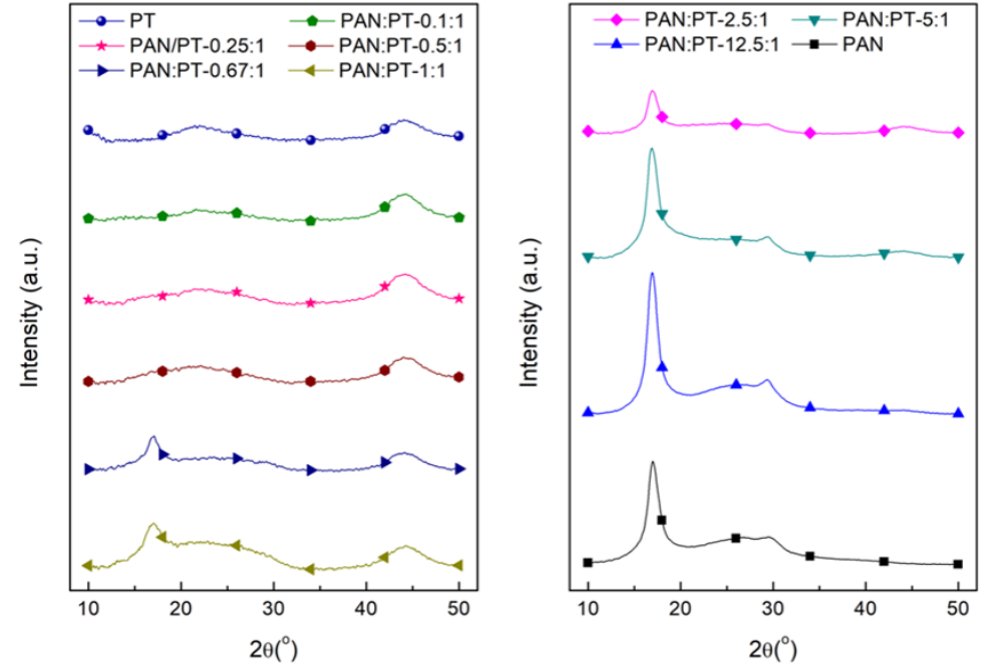
Figure 1. Wide-angle X-ray (WAXD) integrated curves for hPBPs at various PAN/PT weight concen- trations. WAXD curves for the control PAN film and SWNT BP are also included.